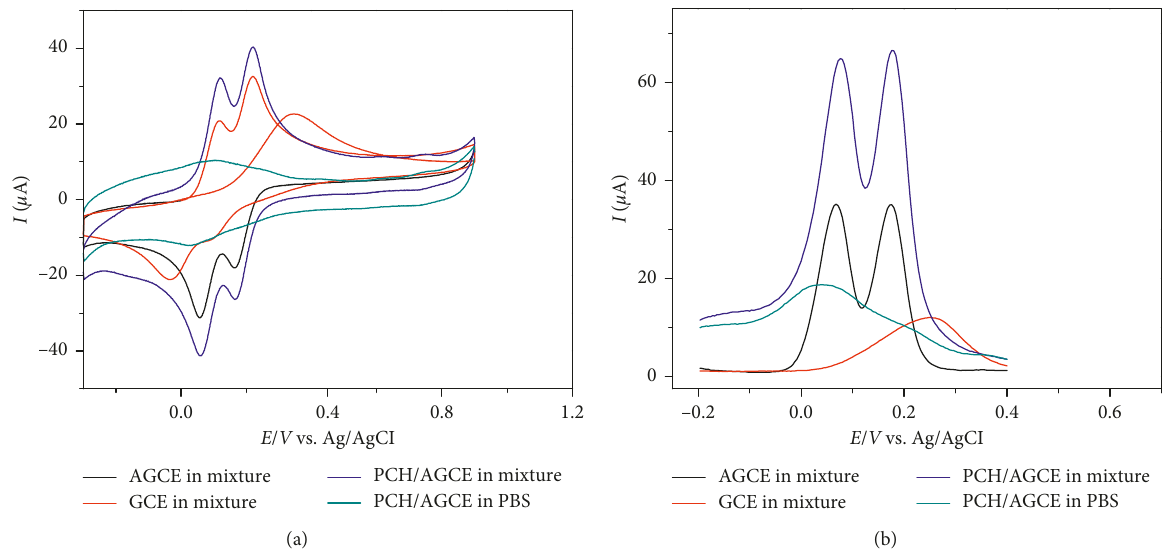
Figure 4: (a) CVs and (b) DPVs of bare GCE, AGCE, and PCH/AGCE in PBS (pH 7.0) and a mixture of HQ and CT (0.5mM of each in PBS, pH 7.0). Scan rate: